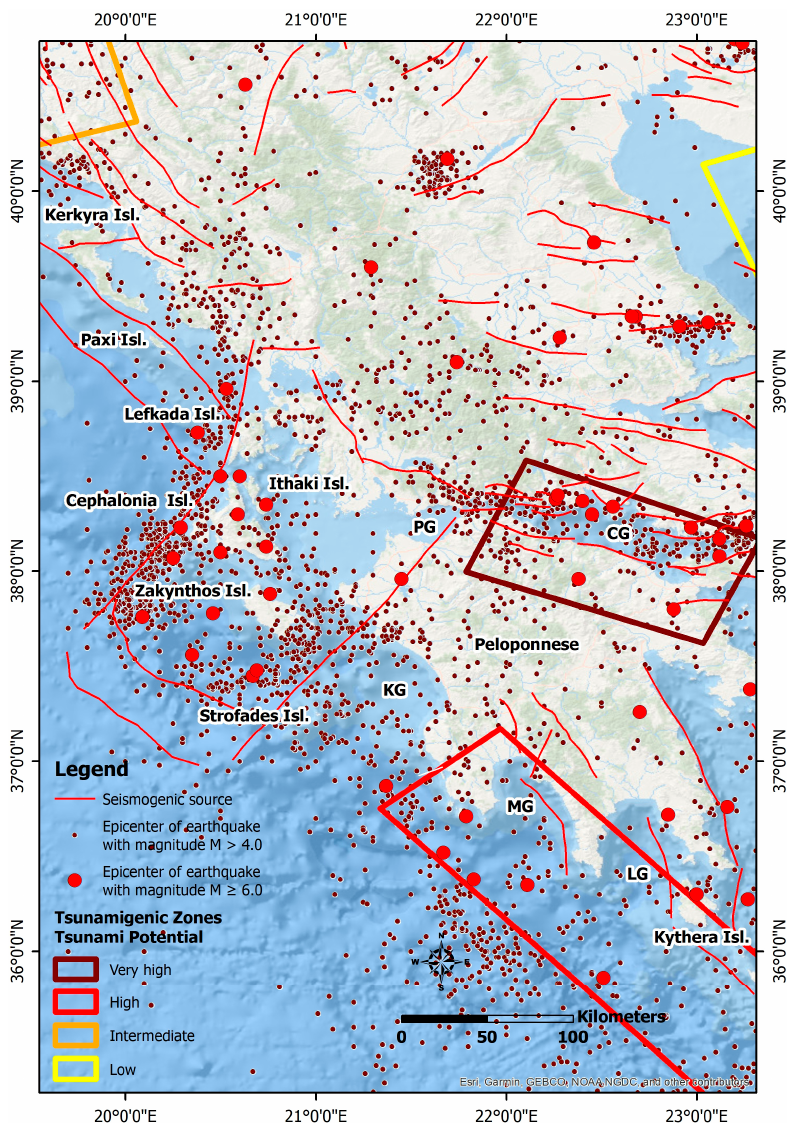
Figure 1. Western Greece comprising the Ionian Islands and offshore western and southern Pelo- ponnese along with the seismogenic sources, the tsunamigenic zones and the epicenters of earth- quakes with M > 4.0 and M ≥ 6.0 based on the earthquake catalogue of Makropoulos et al. [35]. The Ionian Island is not included in the list of tsunamigenic zones of the Eastern Mediterranean region to date, while the zone of the west Hellenic Trench (the area in red frame in the lower right part) is considered a zone of high tsunamigenic potential by Papadopoulos and Fokaefs [33]. The seismo- genic sources are derived from the Greek Database of Seismogenic Sources (GreDaSS) compiled by Caputo and Pavlides